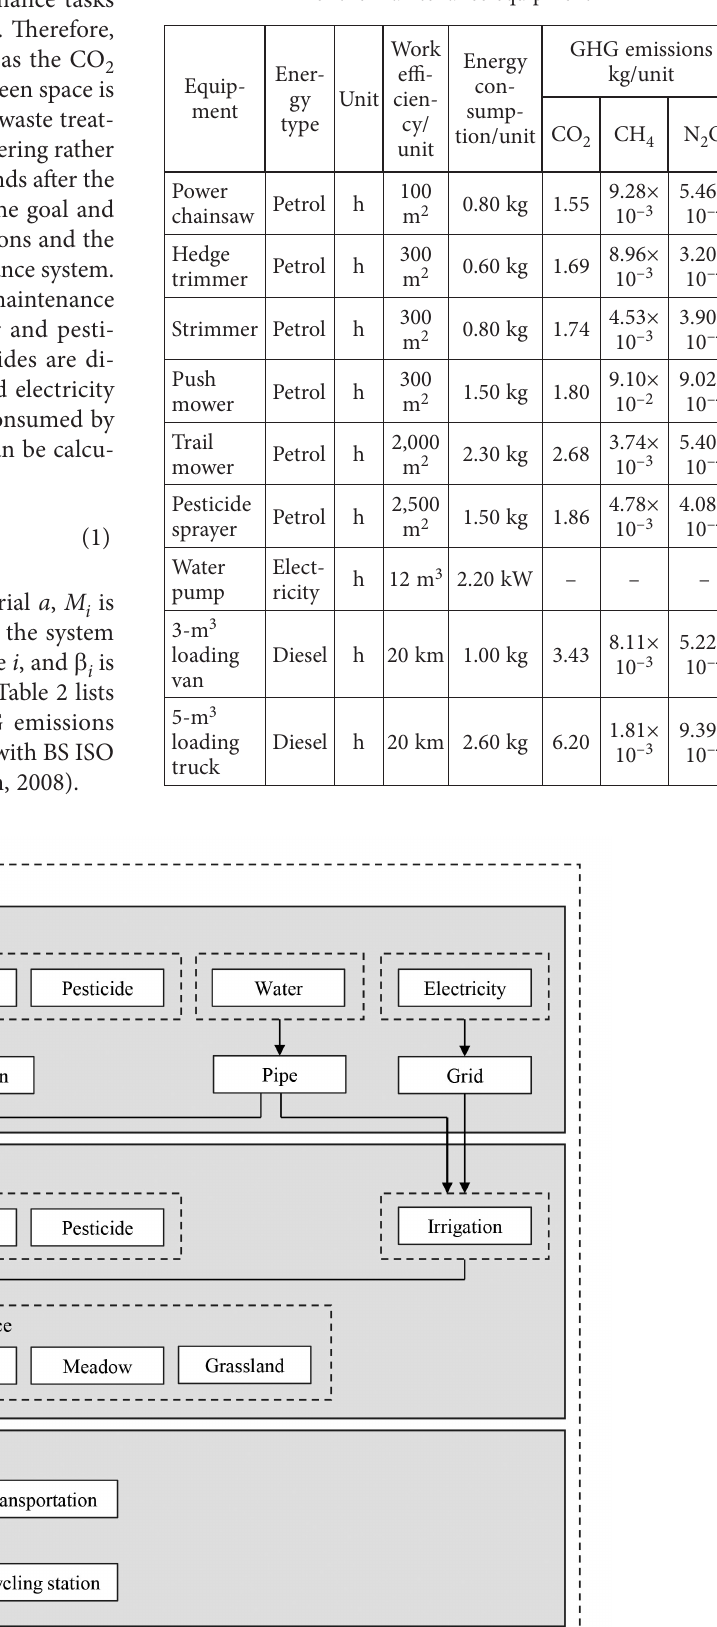
Table 2. Work efficiency and GHG emission inventories